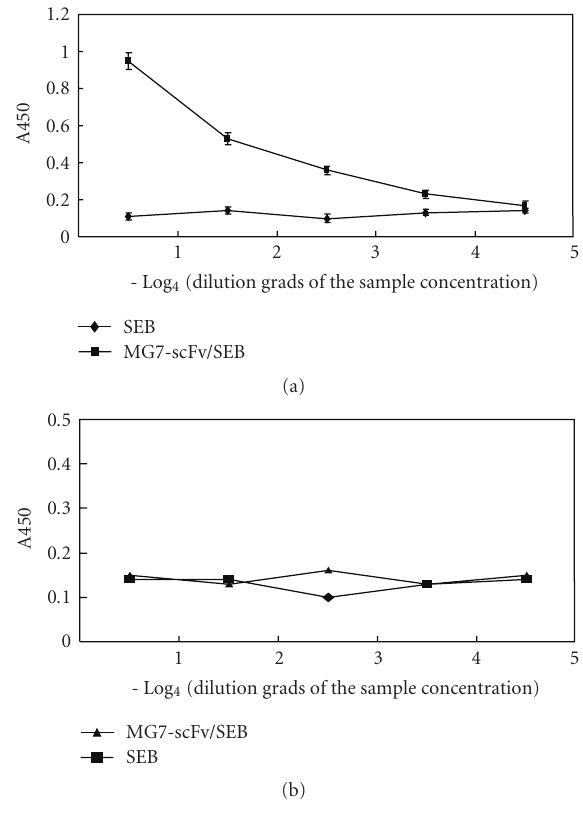
Figure 3: Binding a ffi nity assay of MG7-scFv/SEB to MG7 positive or negative expression cells by cell-ELISA under di ff erent concen- trations, same starting concentration 1.0 μ g, 4 × serial dilution. (a) Binding assay of MG7-scFv/SEB to MG7 positive cell (gastric cancer cell SGC-7901) and (b) binding assay of MG7-scFv/SEB to MG7 negative cell (normal human gastric mucosal cell line